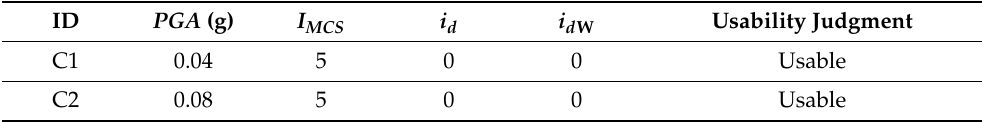
Table 3. Church identification number (ID), peak ground accelerations ( PGA ), and macroseismic intensities ( I MCS ), derived from ShakeMaps according to the geographical location of the church, the vulnerability index i v , the observed and weighted observed damage index ( i d and i d W , respectively), and the usability